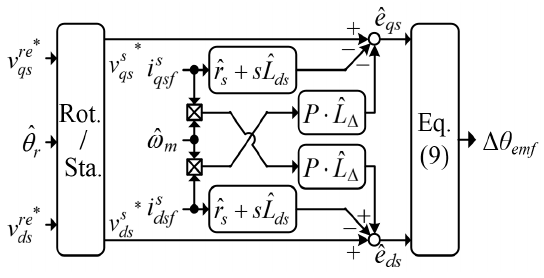
Figure 2. Extended back-EMF estimator.